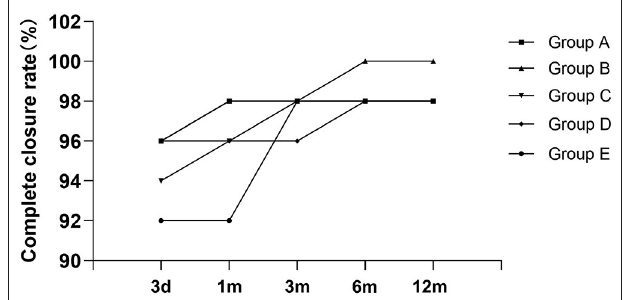
FIGURE 9 | The condition of residual shunt after transcatheter closure. d, days; m, month(s).